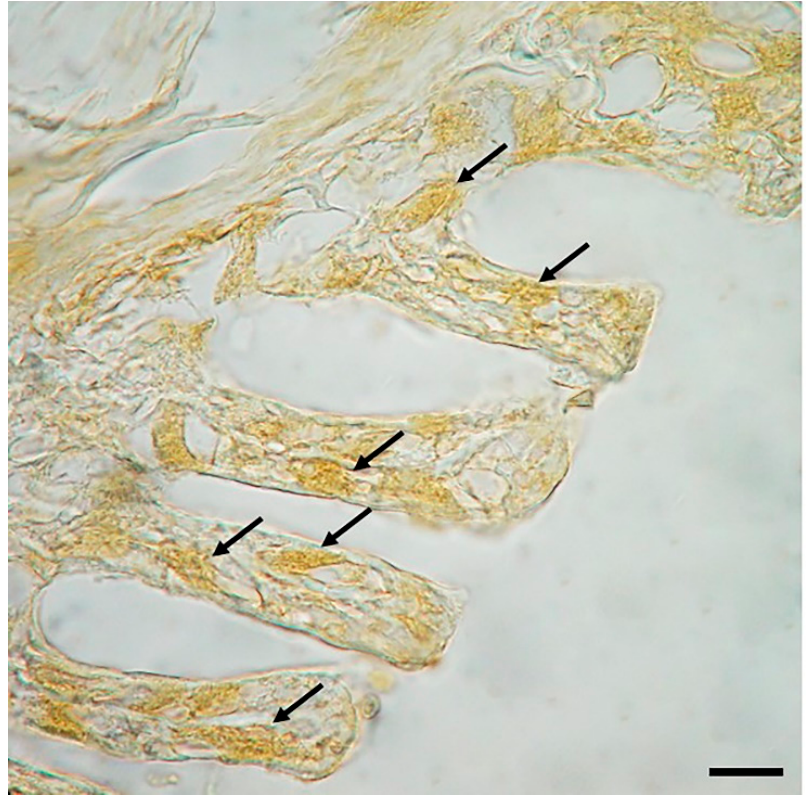
Figure 2. Section of the gill of giant mudskipper, immunoperoxidase, 40×, scale bar 40 μ m. MCs positive to Piscidin1 can be seen in the lamellae (arrows).